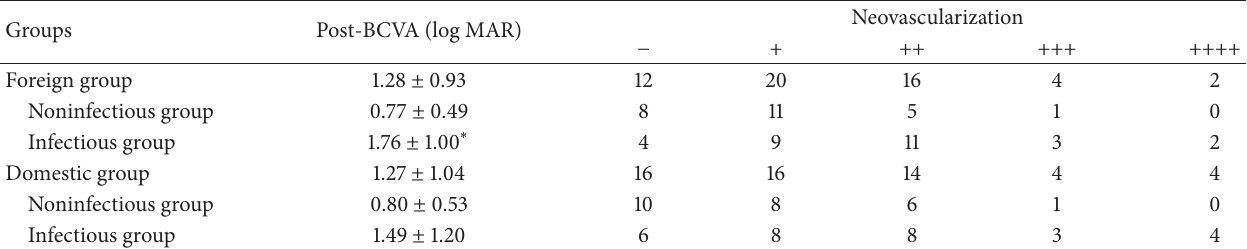
Table 4: BCVA and neovascularization by final follow-up in different